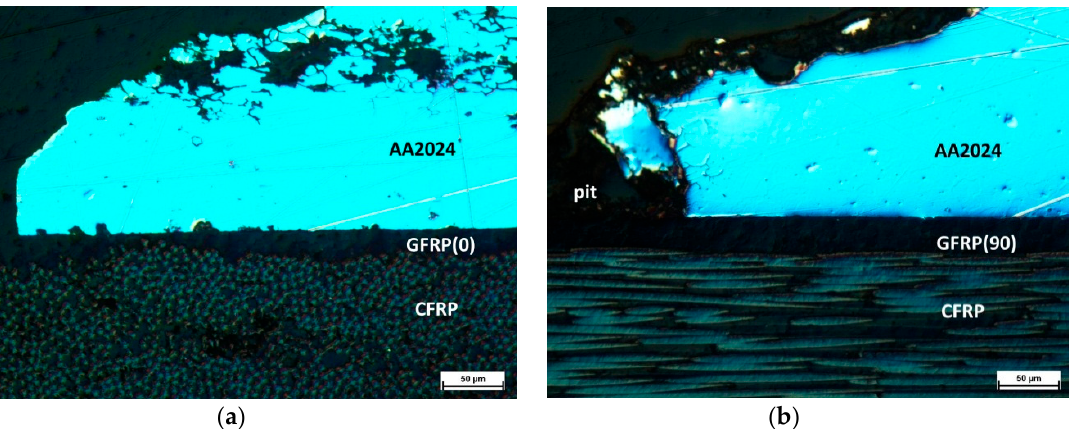
Figure 12. Laminate microstructure: a ) Al-GFRP(0)-CFRP and b ) Al-GFRP(90)-CFRP after 12 weeks in a salt chamber; LM, Nomarski interference contrast.